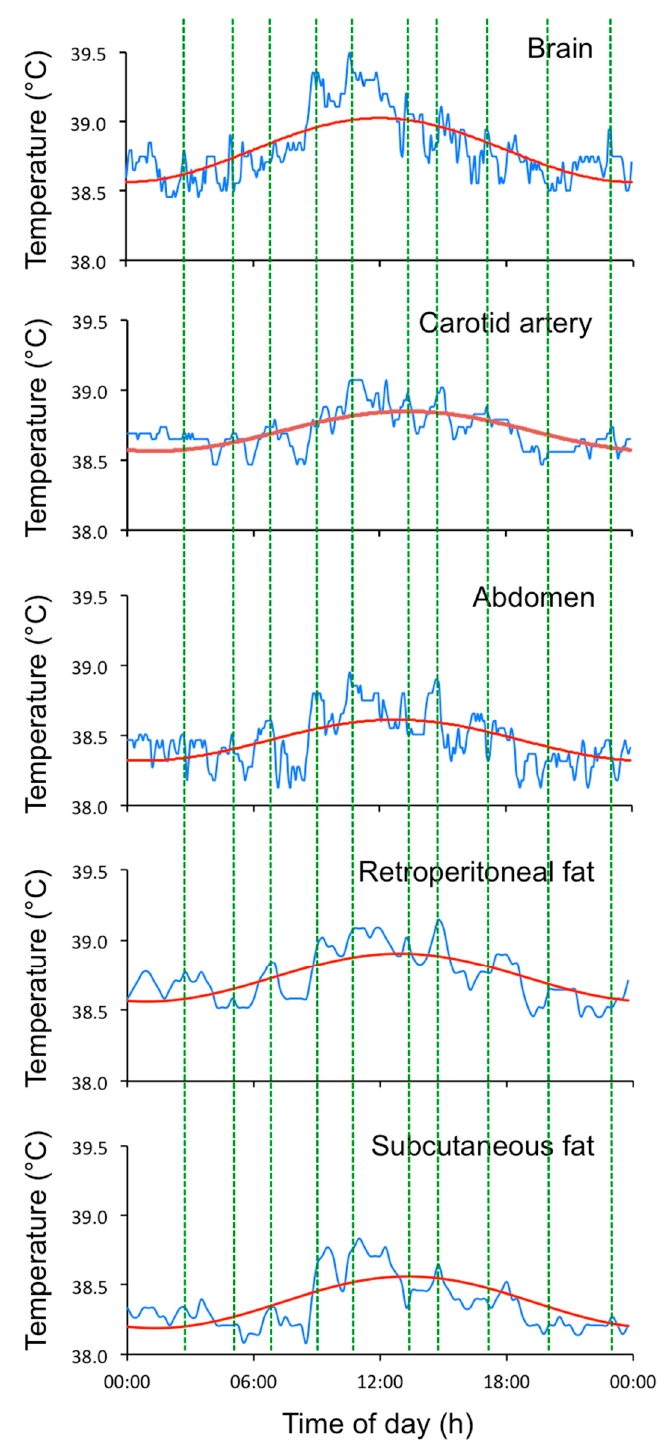
Figure 2. Twenty-four-hour temperature profiles in the brain, carotid artery, abdomen, retroperitoneal fat, and subcutaneous fat of a castrated sheep. The raw data (blue line) were collected from the brain, carotid artery, and abdomen every 1 min and from the two fat tissues every 5 min. The circadian patterns (red line) were fitted to the data using a cosinor analysis [17]. There is a visible synchrony between most of the episodic ultradian events (EUEs) across the different tissues (vertical lines). The sheep was kept indoors under a 12/12 h dark–light cycle and fed at requirement level at 09:00 [12].